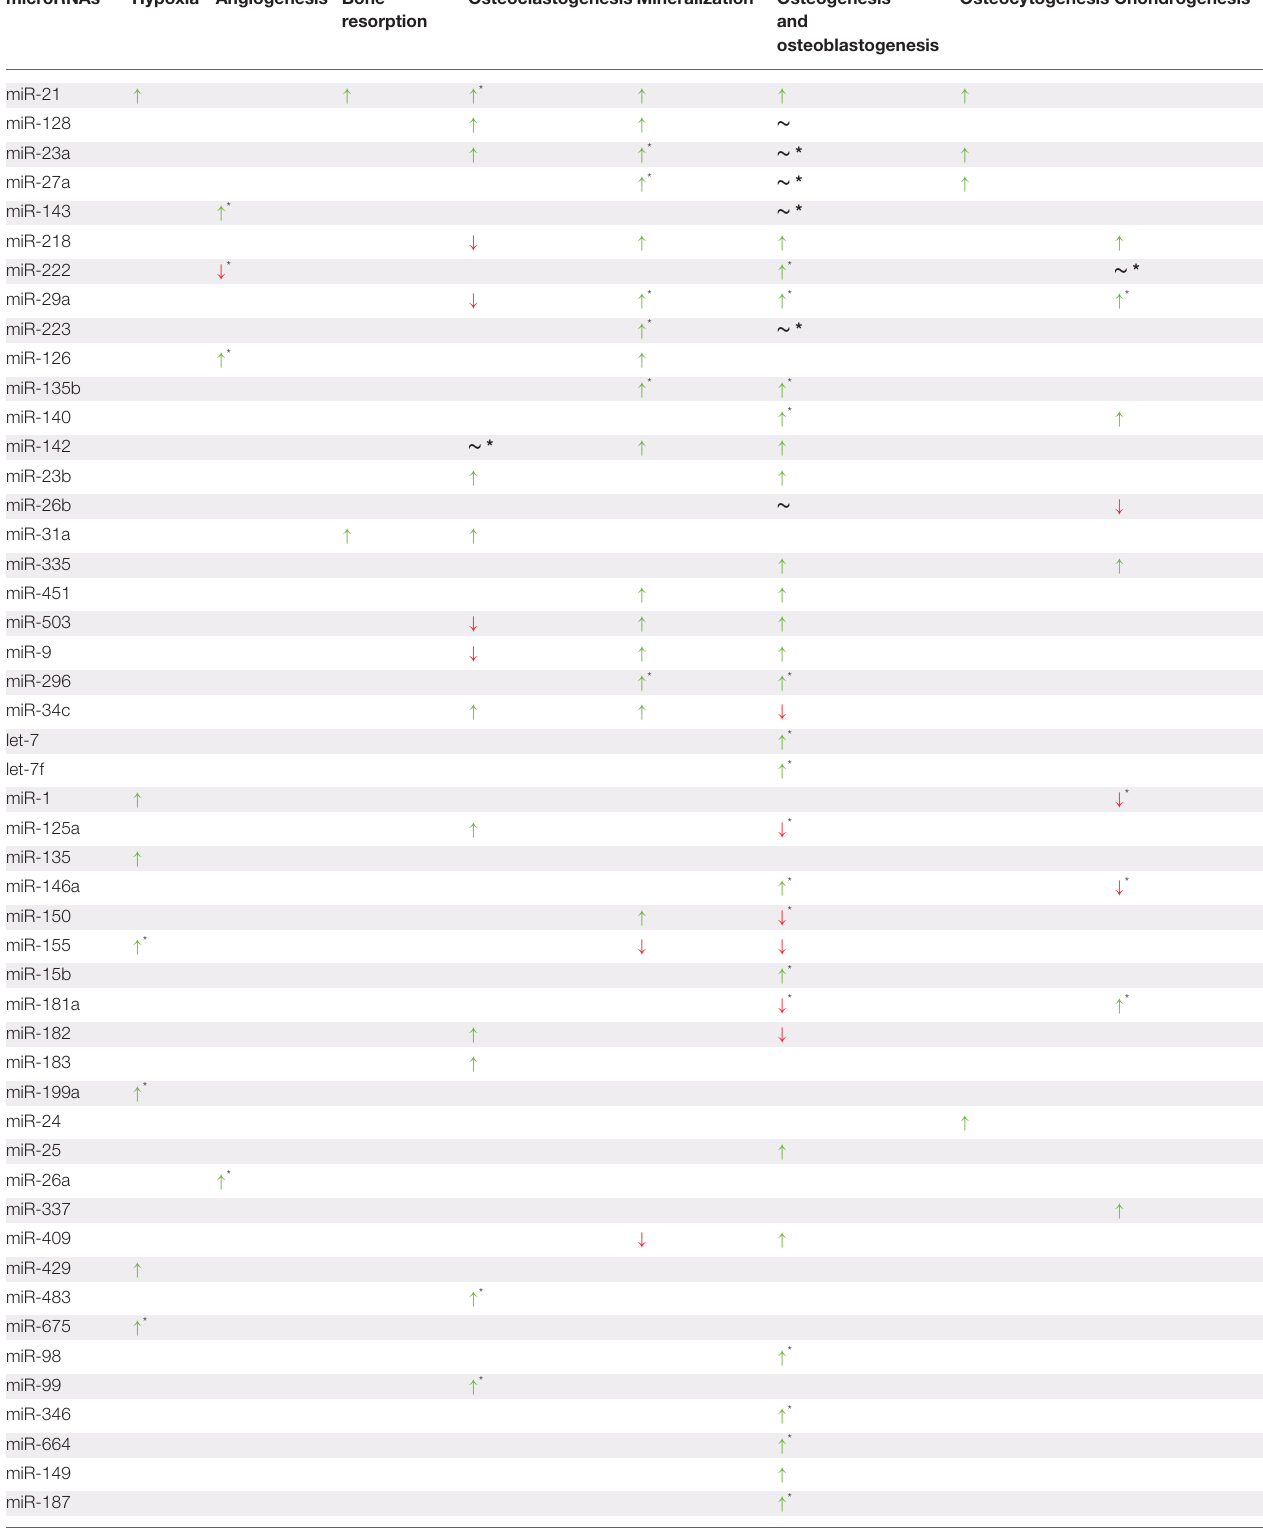
TABLE 1 | miRNAs and their involvement in different aspects of fracture healing. microRNAs Hypoxia Angiogenesis Bone